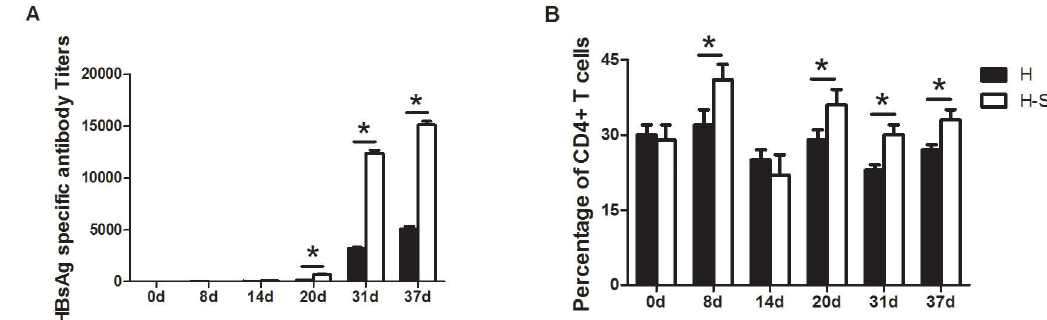
Fig 5. SBP adjuvanted hepatitis B vaccine could induce higher antibody titers and higher percentage of Th cells. Macaca fasciculariswere immunizedintramuscularly at days 1, 9, 15, 32 with vaccine alone (H) or together with SBP (H-S). (A) Blood samples were collectedon indicatedtime points and HBsAg specific antibody titers were measured. (B)Percentage of CD4+ T cells was also measuredat these time points. Results are expressedas the means ± SEM, * p <